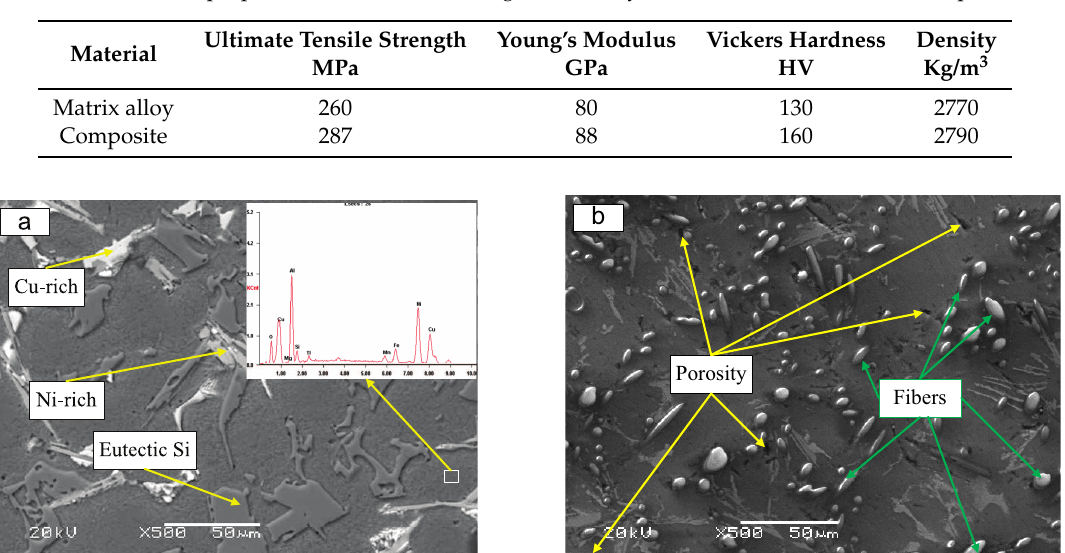
Table 1. The chemical composition of the analyzed Al-12Si-CuNiMg matrix alloy. (in wt.%)